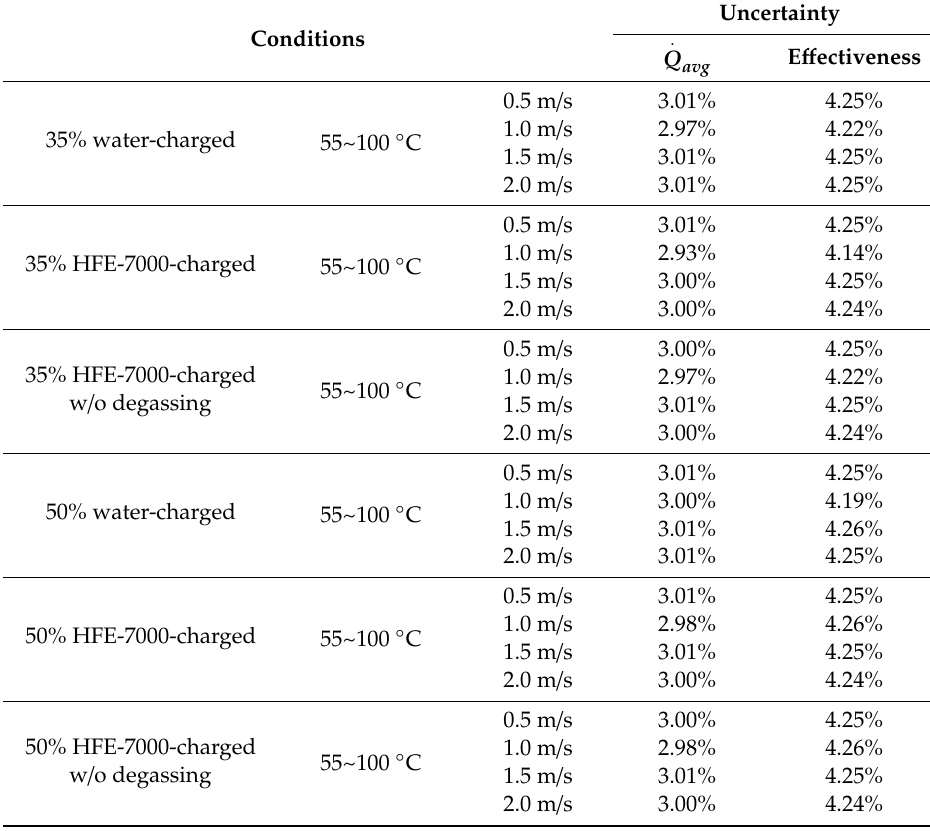
Table 1. Uncertainty of the average heat transfer rate and e ff ectiveness of the heat